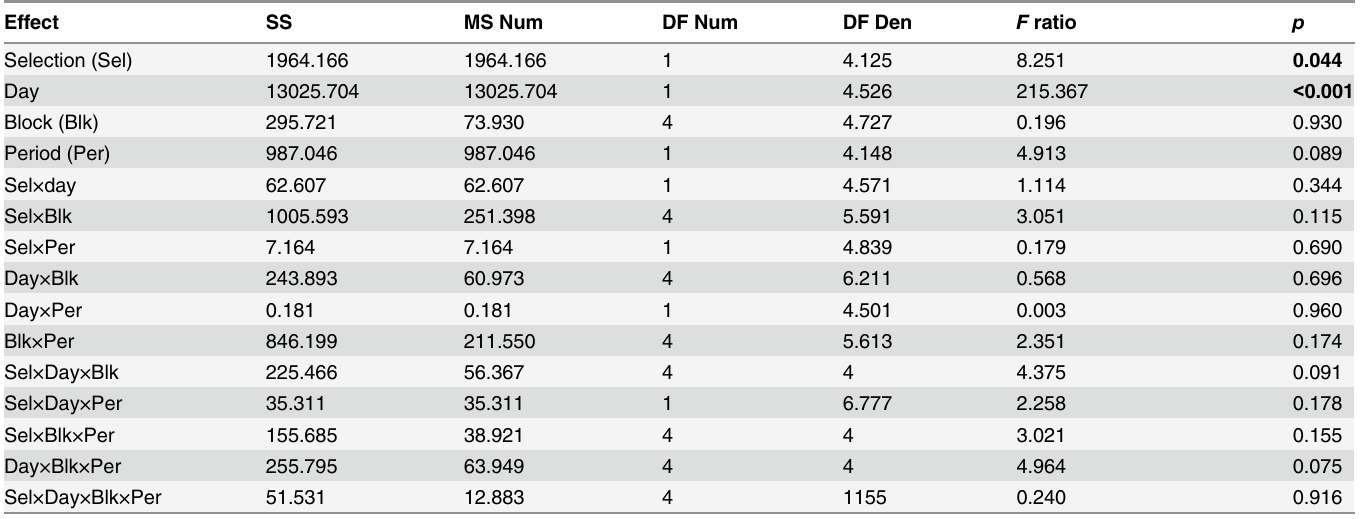
Table 3. Progeny production of ancestral females after exposed with cold shocked males. Summary of results from a four-factor ANOVA using selec- tion regime (FSB and FCB), period (recovery period 4 hours and 12 hours post cold shock) and day (progeny production on day1 and day 2) as fixed factors crossed with block (1 – 5) as random factor on the progeny production of females mated to FSB or FCB males (number of progeny from each vial was used as unit of analysis). p -values in bold are statistically